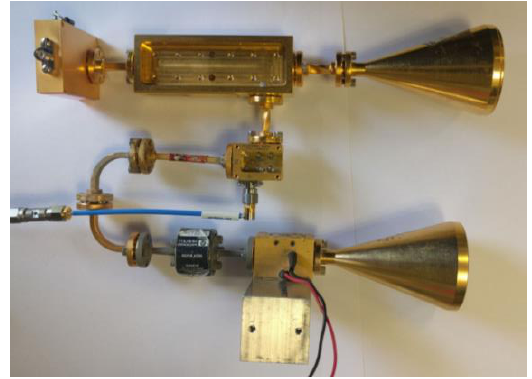
Figure 3. The continuous wave micro-Doppler radar.